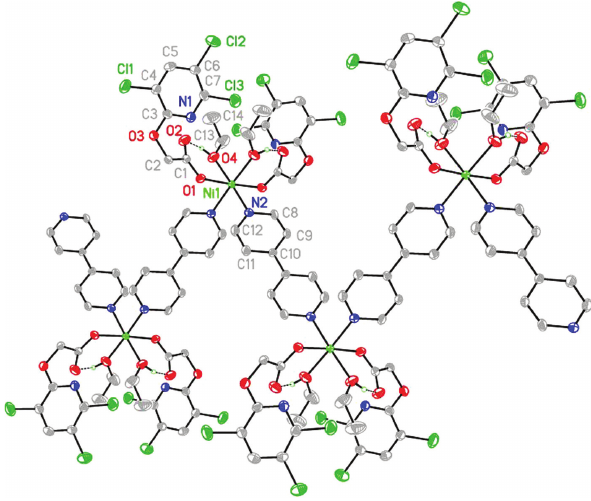
Apartofthemolecularstructureisshowninthefigure.Table1